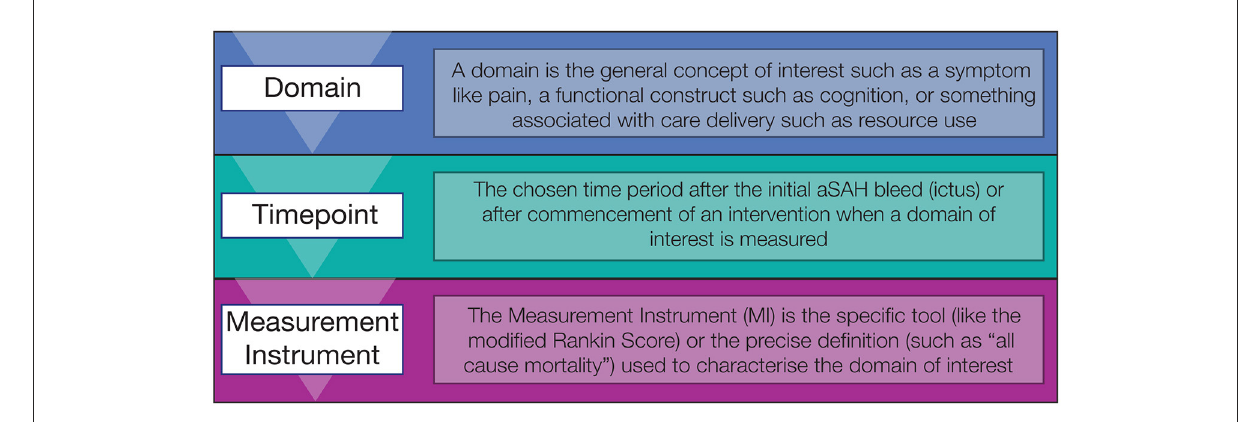
FIGURE1 Three step process for selecting outcome measures in aSAH, starting with the domain of interest, the timepoint and then measurement